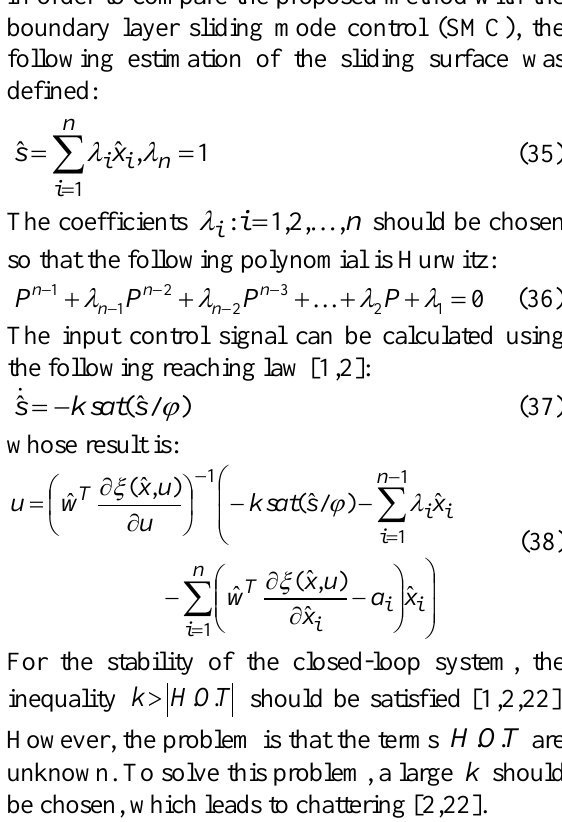
Figure 18. Second state and its